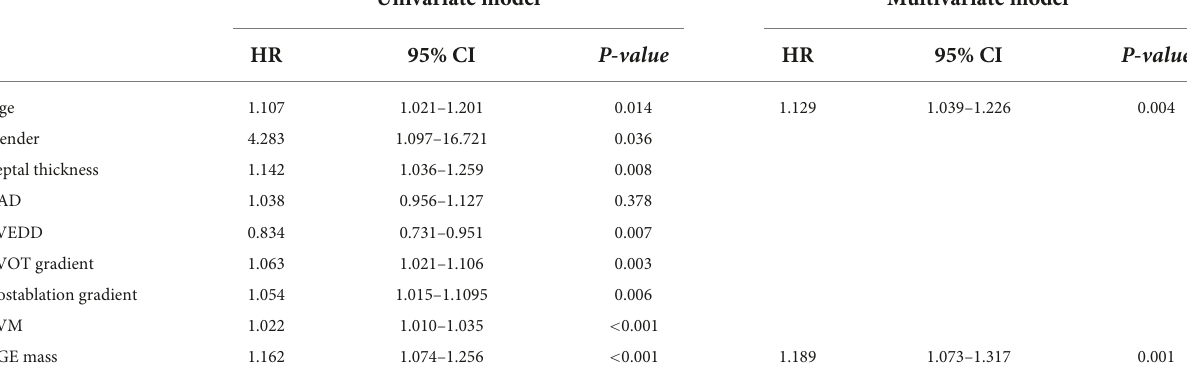
TABLE 4 Univariate and multivariate predictor models for SCD events in HCM patients undergoing